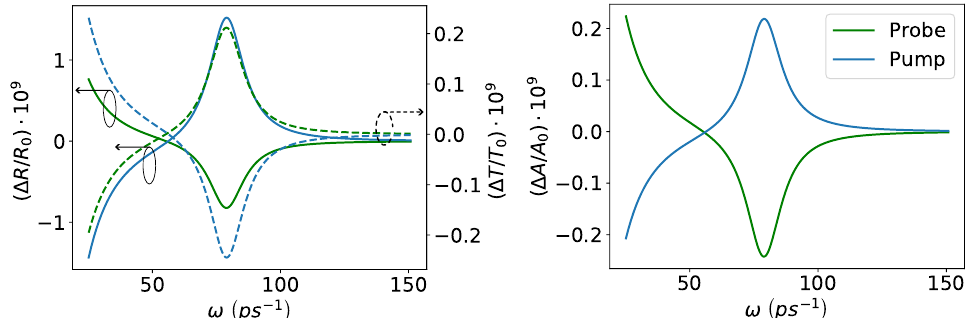
Figure 4. Differential reflectance ( left , solid lines), transmittance ( left , dashed lines), and absorbance ( right ) of the pump (blue curves) and probe (green curves) beams as functions of ω . Here the Fermi = 40 ◦ , while other parameters are the same as in Figure 3. The energy E F = 500 meV, θ I a = 20 ◦ , and θ I b plasmon resonance is observed at approximately ω SP = 80ps − 1 . We assumed the same intensities for both optical beams, I a = I b = 10 16 erg cm − 2 s − 1 , in order to facilitate the